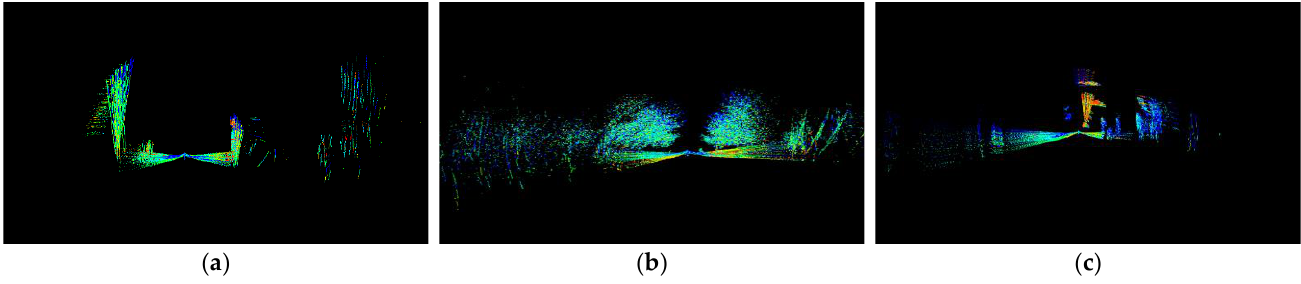
Figure 14. Point cloud image scene 10: Mason-Hall-S16 ( a ) Picture 1, ( b ) Picture 2, ( c ) Picture 3.